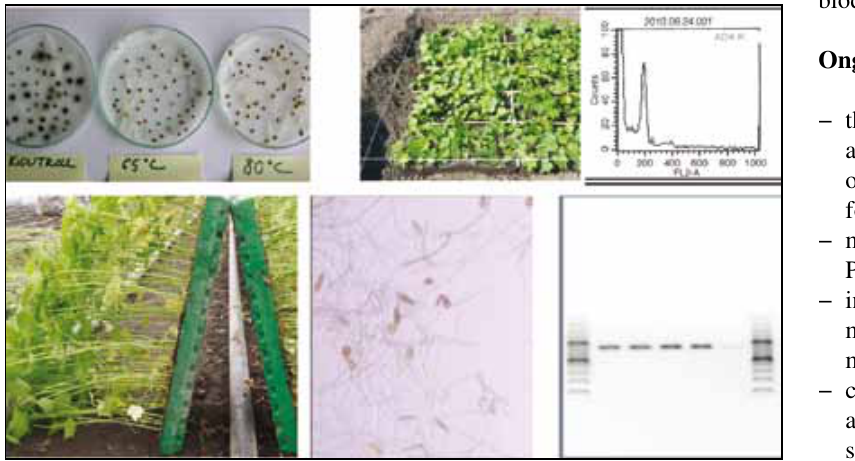
Figure 8: Creation of ex situ genebank from the new and former Italian cane ecotypes for preservation of biodiversity of population